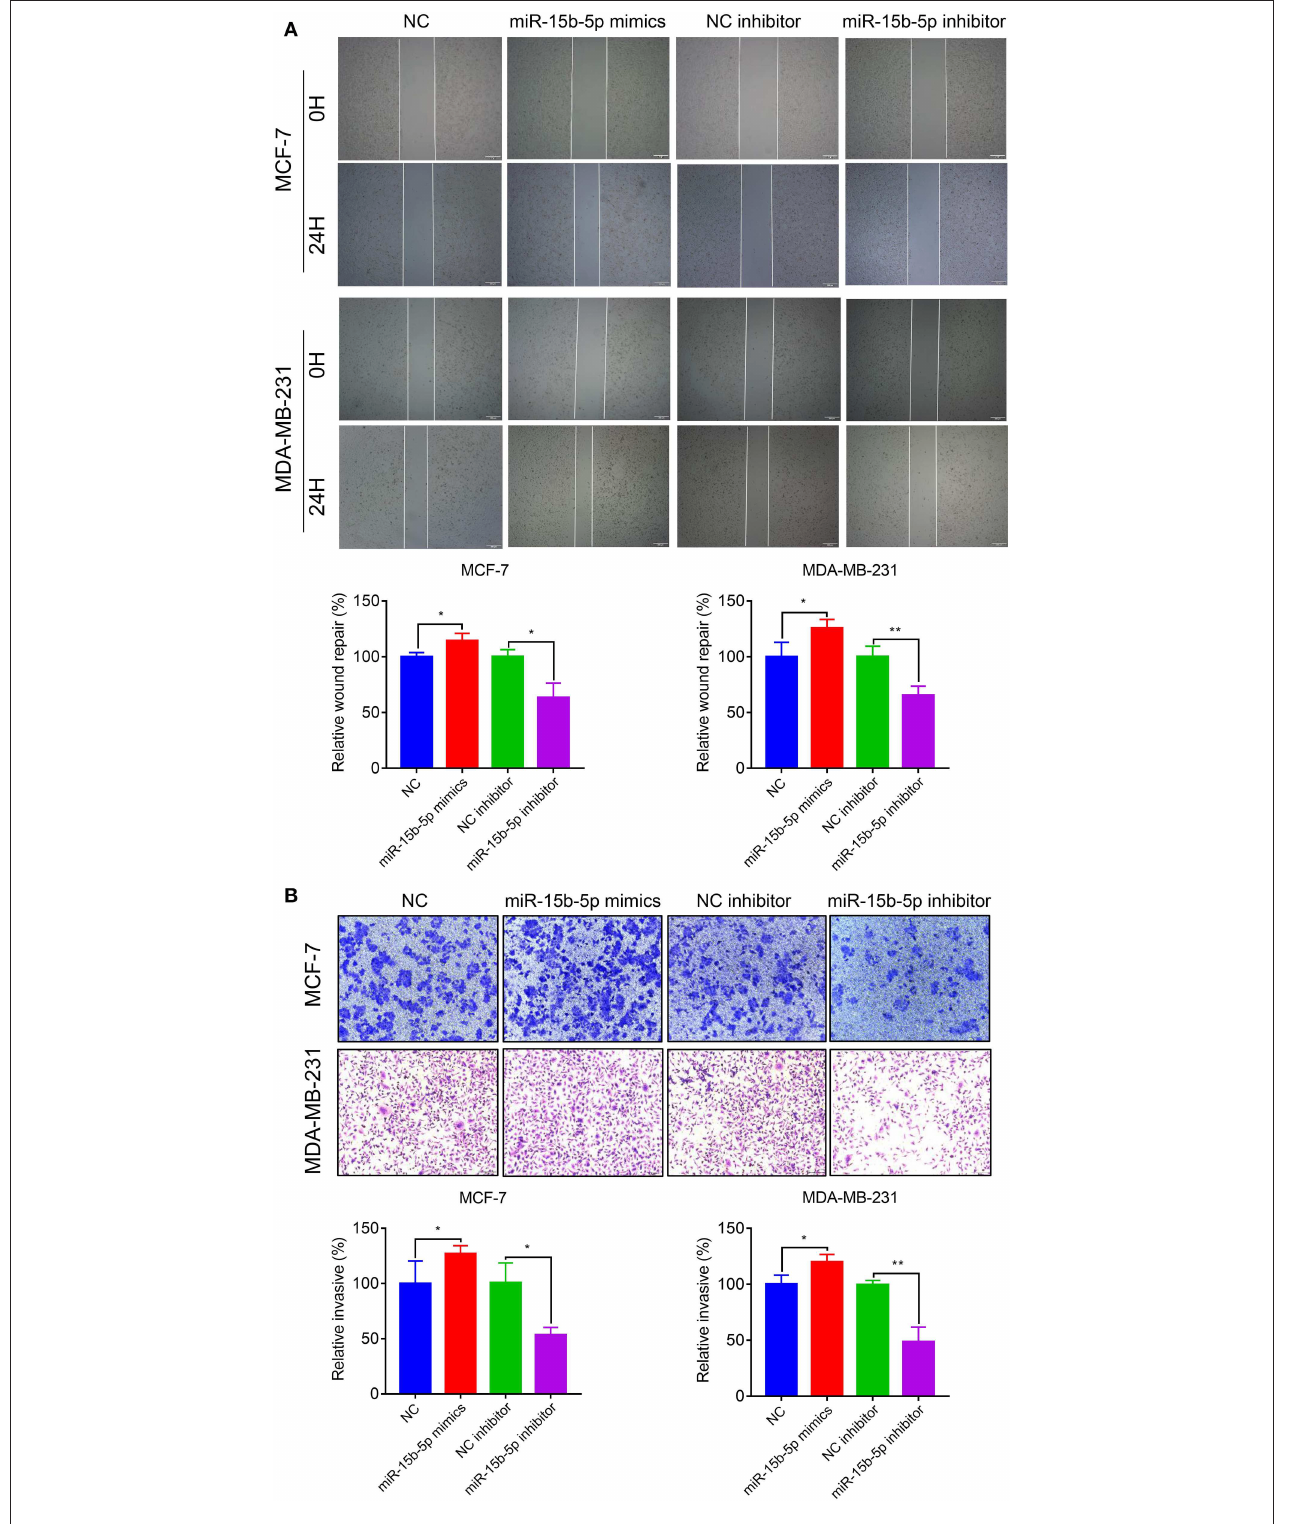
FIGURE 5 | Downregulation of miR-15b-5p suppresses the motility and invasiveness in BC cells. (A) Cell migration was measured by scratch-wound assay. Representative images are shown (20 × ). The results of three independent experiments are summarized. (B) Cell invasion was determined by Transwell assay. Representative images are shown (100 × ). The results of three independent experiments are shown (* P < 0.05 and ** P < 0.01).